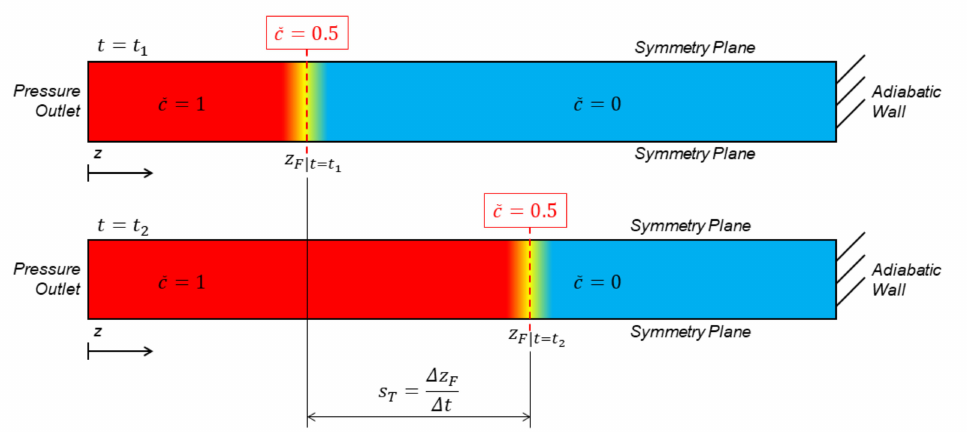
Figure 3. Sketch of the test case adopted for turbulent flame speed measurement at two generic instants t 1 and t 2 . The unburnt mixture ( (cid:101) c = 0, blue) is on the right side and the burnt products ( (cid:101) c = 1, red) are on the left